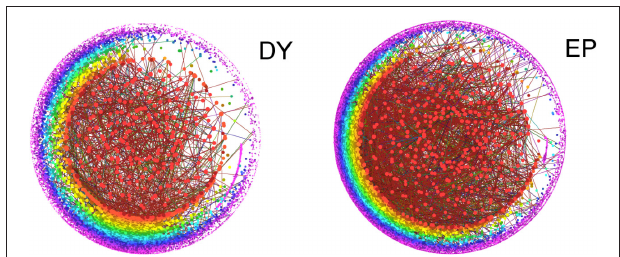
FIGURE 2 | k-shell structure of the trust networks, where nodes have a color and position according to their coreness, and size according to their degree. The plots were created using the LaNet-vi software [51].